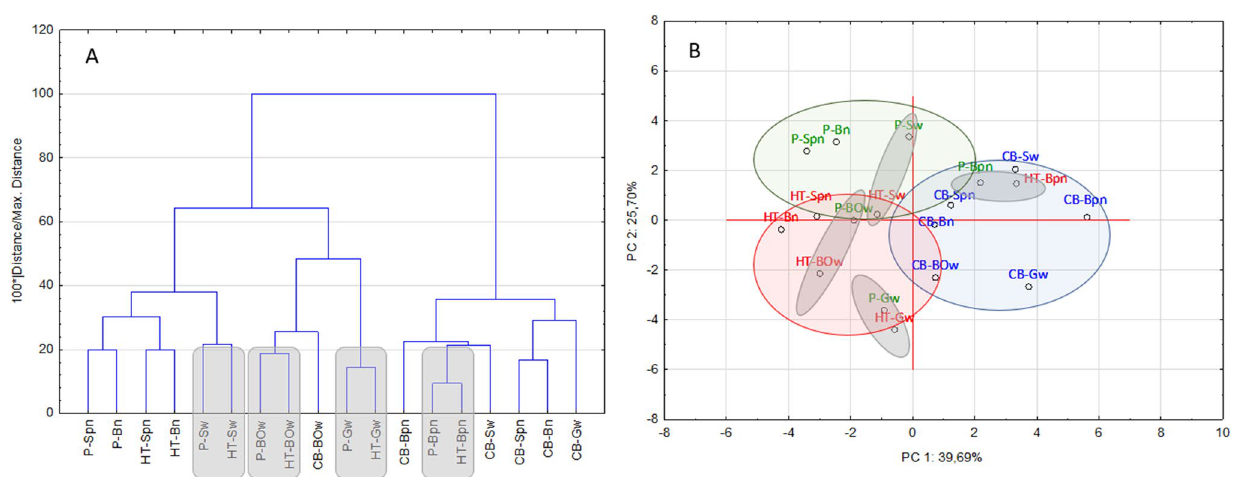
Figure 4. Chemical, antioxidant and sensory discriminants for coffee brews. ( A ) Agglomerative hierarchical cluster analysis- dendrogram. ( B ) Principal component analysis (Statistica, ver. 10,